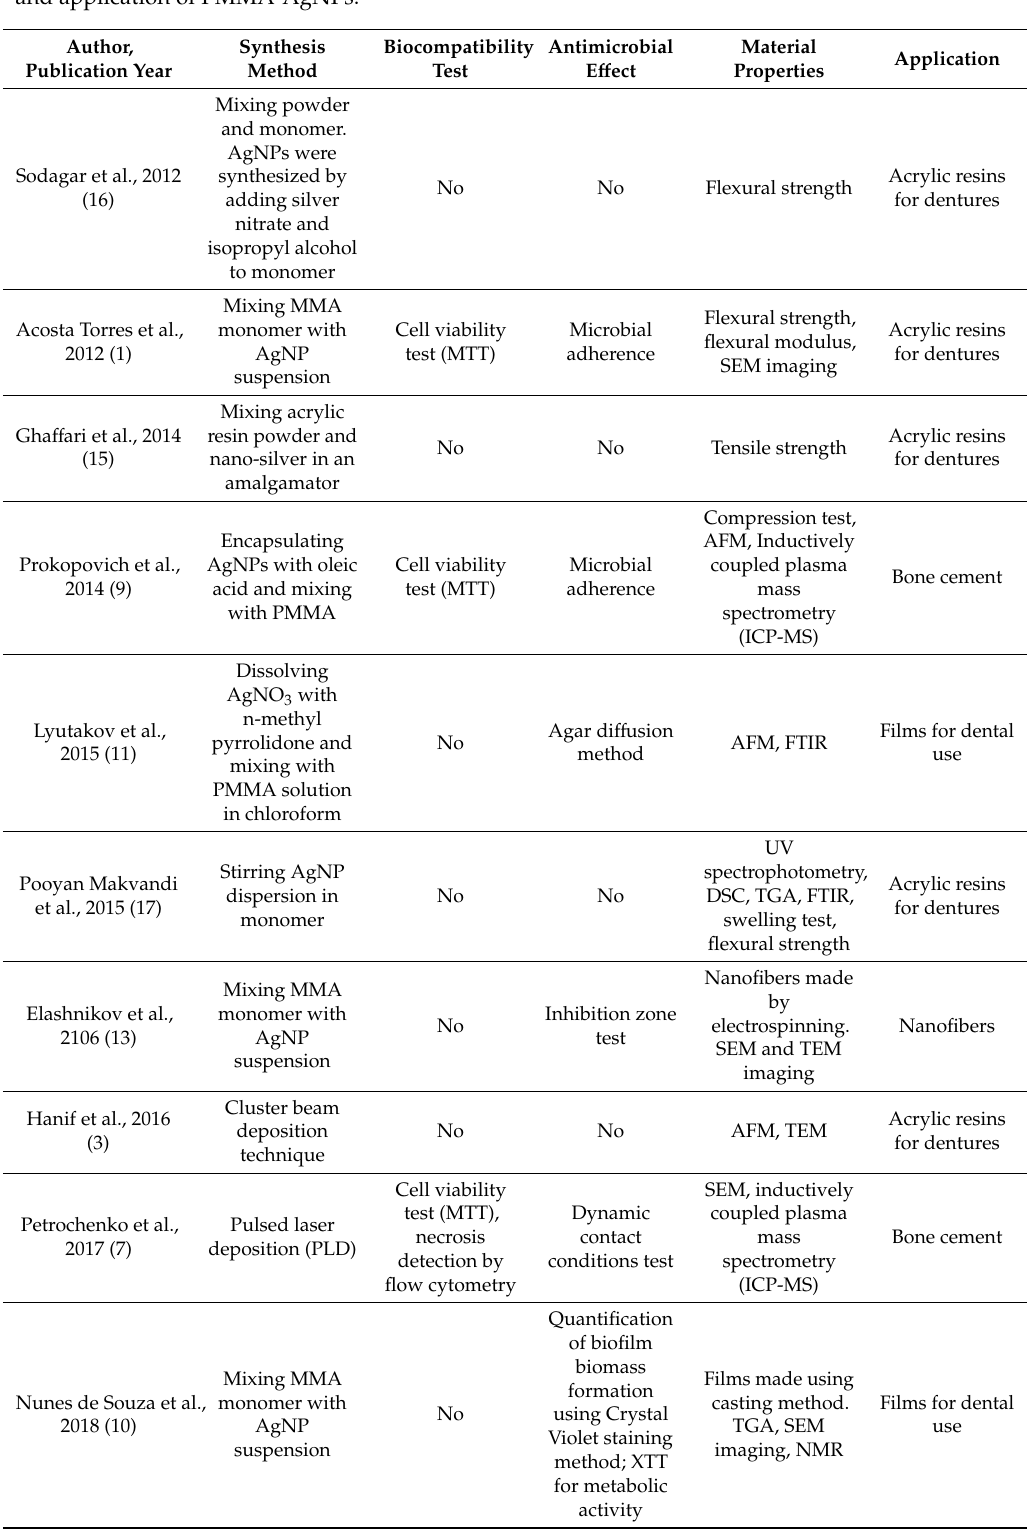
Table 1. Synthesis methods, biocompatibility tests, antimicrobial tests, evaluation of material properties and application of